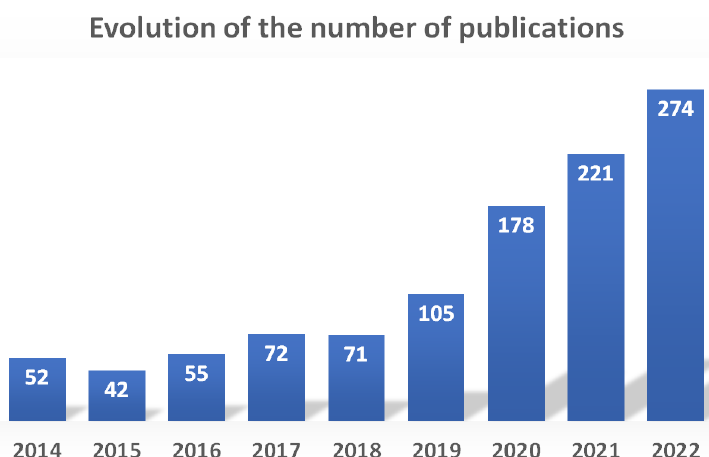
Figure 1. Evolution of the number of contributions (indexed in the ISI Web of Science for year 2014 to 2022) in the field of deep learning techniques applied to colorectal cancer.